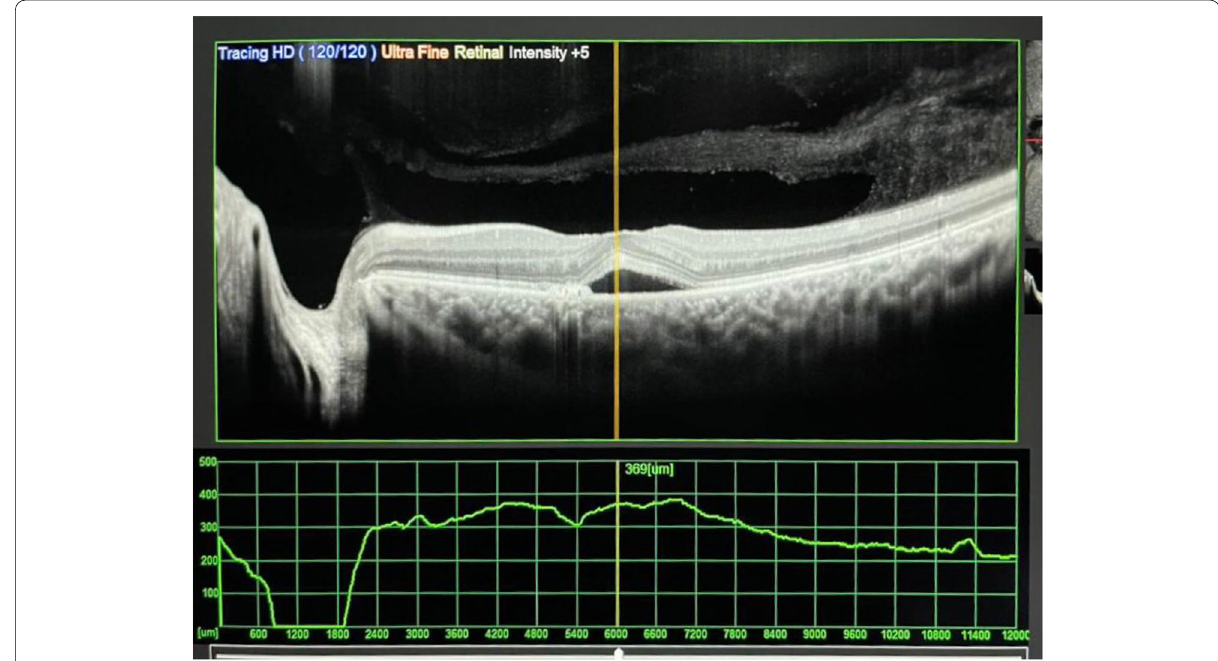
Fig. 3 Ocular coherence tomography of the right eye showing detached retinal pigmentary epithelium (white arrow)